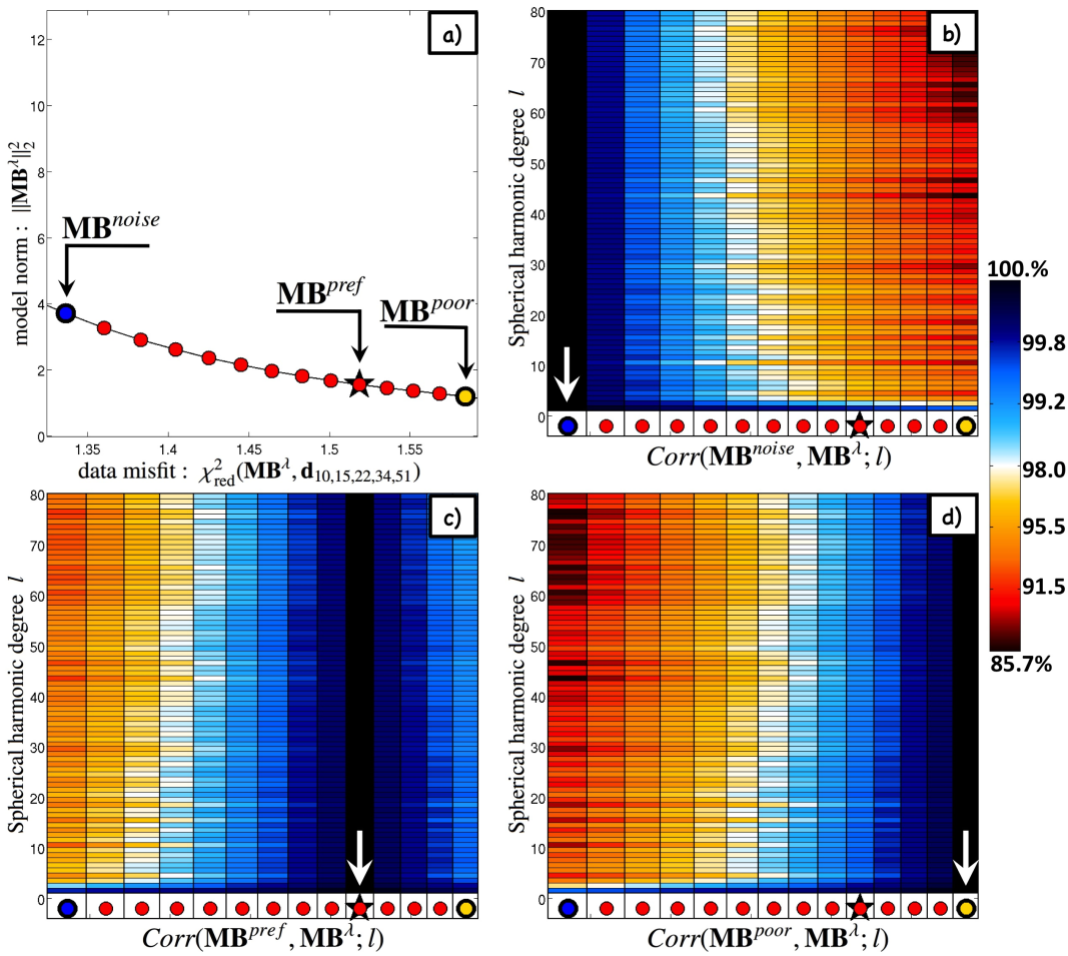
Fig. 5. Illustration showing that the selection of our preferred multi-band model MB pref (black star) is quasi-objective in terms of model in- terpretation. (a) Trade-off curve corresponding to the “optimal range” of models, after identification of those “dominated by noise” ( MB noise ) or with “poor data exploitation” ( MB poor ). (b–d) Plot of the correlation of three specific models ( MB noise , MB pref , MB poor , as indicated by white arrows) with several models MB λ spanning the “optimal range” of models (respectively). Correlation is shown for spherical harmonic degrees l = 1–80, and is displayed using the colour scale on the right (black is 100%, and white is 98%). One sees that MB pref has a corre- lation coefficient greater than 98%, up to degree l = 80, with respect to almost all models MB λ within the optimal range. The characteristic horizontal length associated with l = 80 is ∼ 400km. Here, the correlation is shown for models averaged over 960–1510km depth, but we checked that it holds true at other